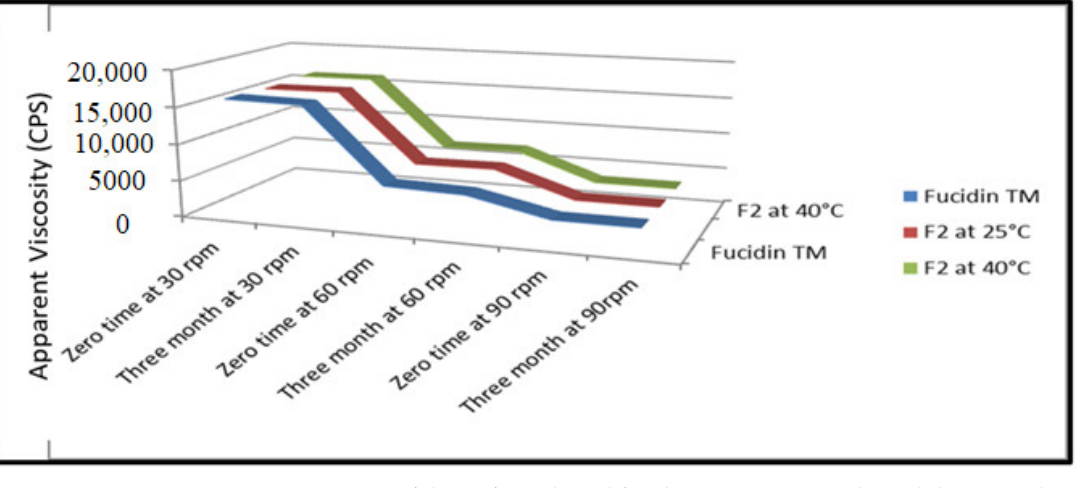
Figure 2. Viscosity of the F2 formula and fucidinTM at zero months and three months at 25 °C and accelerated conditions (40 ± 2 °C/75% ± 5% RH).